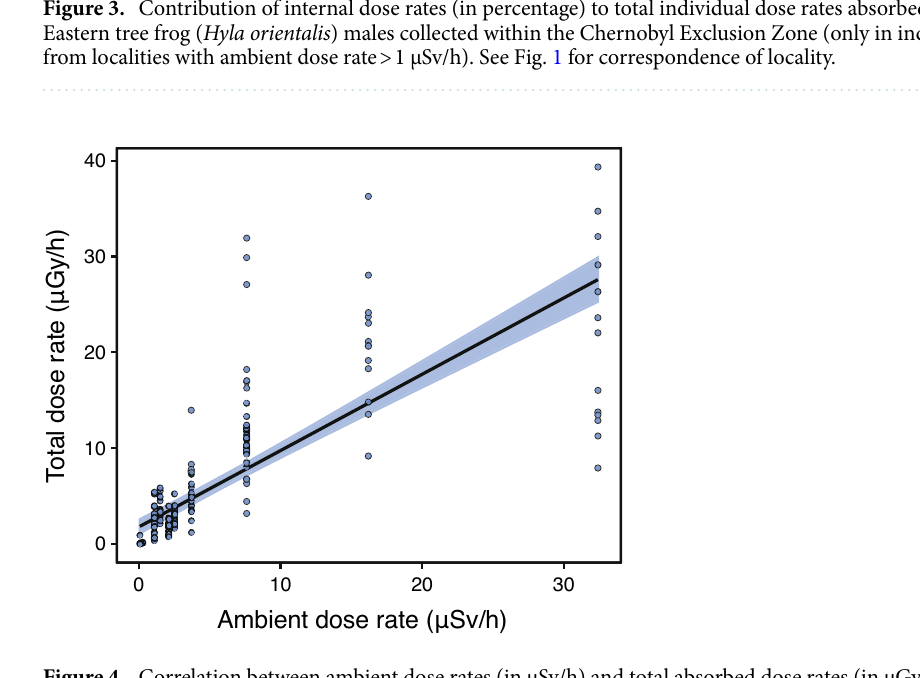
Figure 4. Correlation between ambient dose rates (in μSv/h) and total absorbed dose rates (in μGy/h) in breeding Eastern tree frog ( Hyla orientalis ) males living in the Chernobyl Exclusion